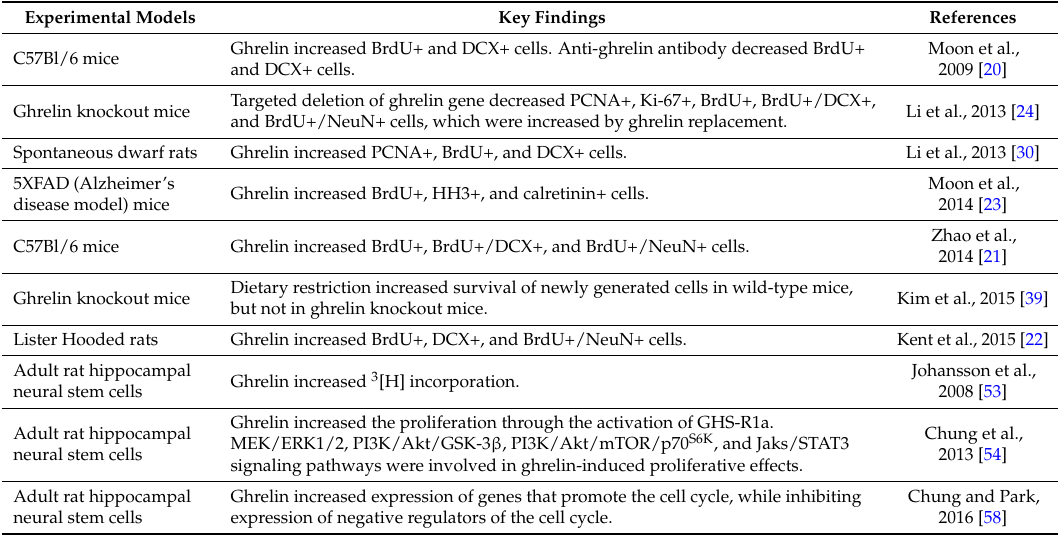
Table 1. Summary of the effects of ghrelin on adult hippocampal